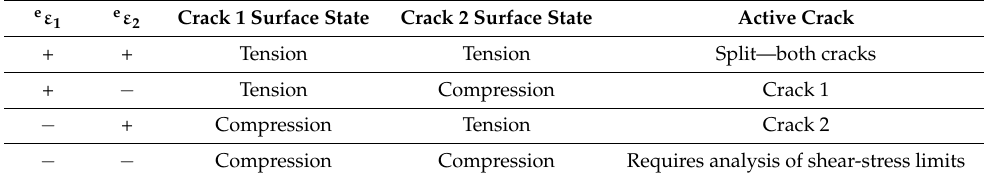
Table 5. Summary of active crack criteria.